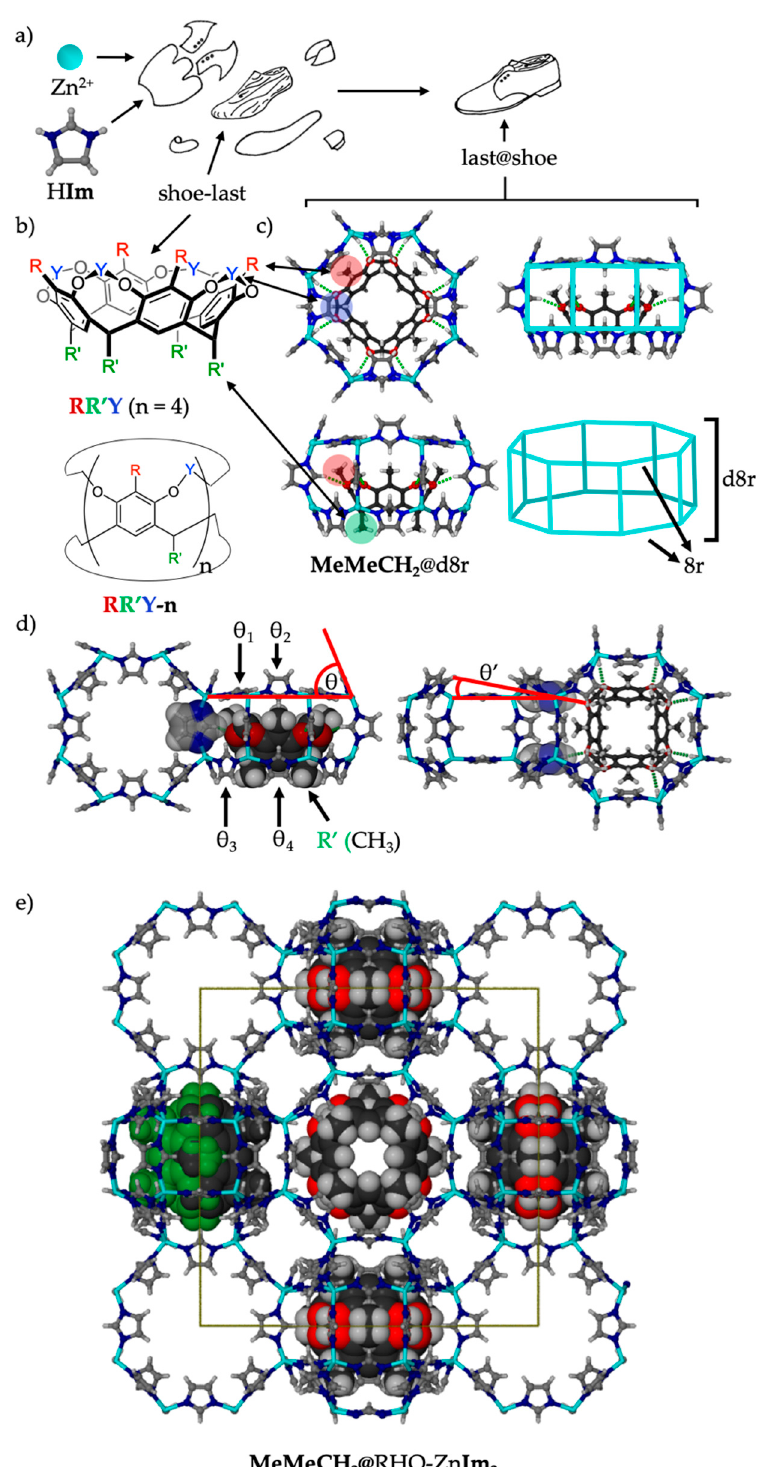
Figure 1. ( a ) Schematic representation of the “shoe-last” templating approach. ( b ) Cavitand naming scheme illustrating the rccc forms of RR’Y- n (where omitted, n = 4). ( c ) Top-down and side views of the general MeMeCH 2 @ d8r motif. MeMeCH 2 is bound via eight C-H···O hydrogen bonds (green dashes). ( d ) Crystal structure of MeMeCH 2 @RHO-Zn 16 ( Im ) 32 ·solvent, illustrating the fused empty and occupied d8r s with the empty d8r shown from the top and filled from the side (left) and vice-versa (right). Relevant θ angles of different 8r imidazoles are pointed out. ( e ) The crystal structure of MeMeCH 2 @RHO-Zn Im 2 ⋅ x (solvent) as a ball-and-stick representation. Half of the d8r s are occupied by a (disordered) MeMeCH 2 cavitand, shown in spacefill. The disorder is represented by green and black color on one of the cavitand molecules.